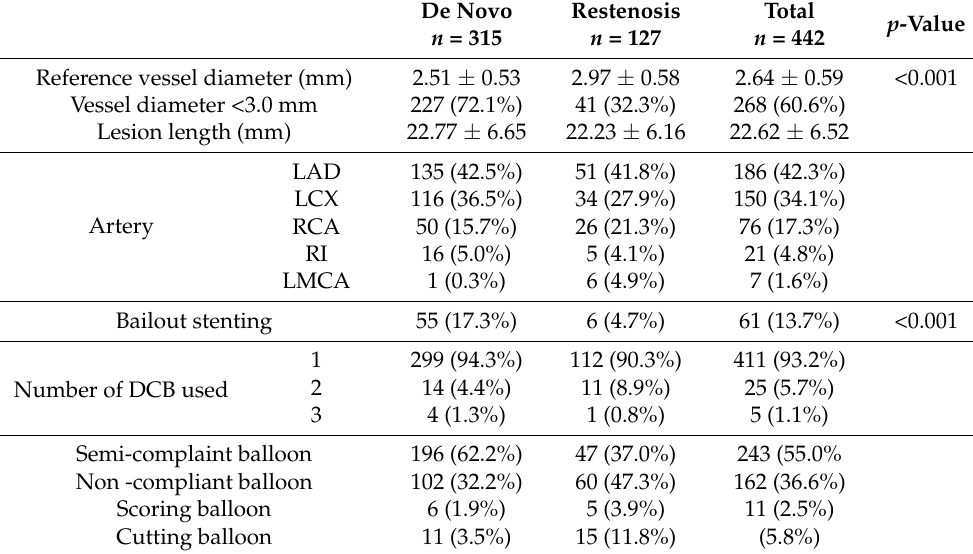
Table 2. Procedure data.